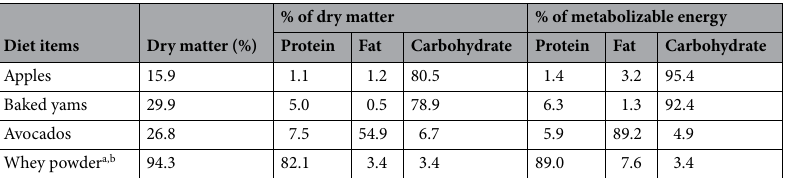
Table 2. Macronutrient composition of the foods offered to sloth bears used to determine their preference for protein, fat, and digestible carbohydrates. Nutritional data on apples, baked yams, and avocados from USDA 51 . a Optimum Nutrition, Downers Grove, IL. b The whey solution used in the study was made by adding 15.5 g of powder to 100 g water to create a 10.5% (w/w) protein